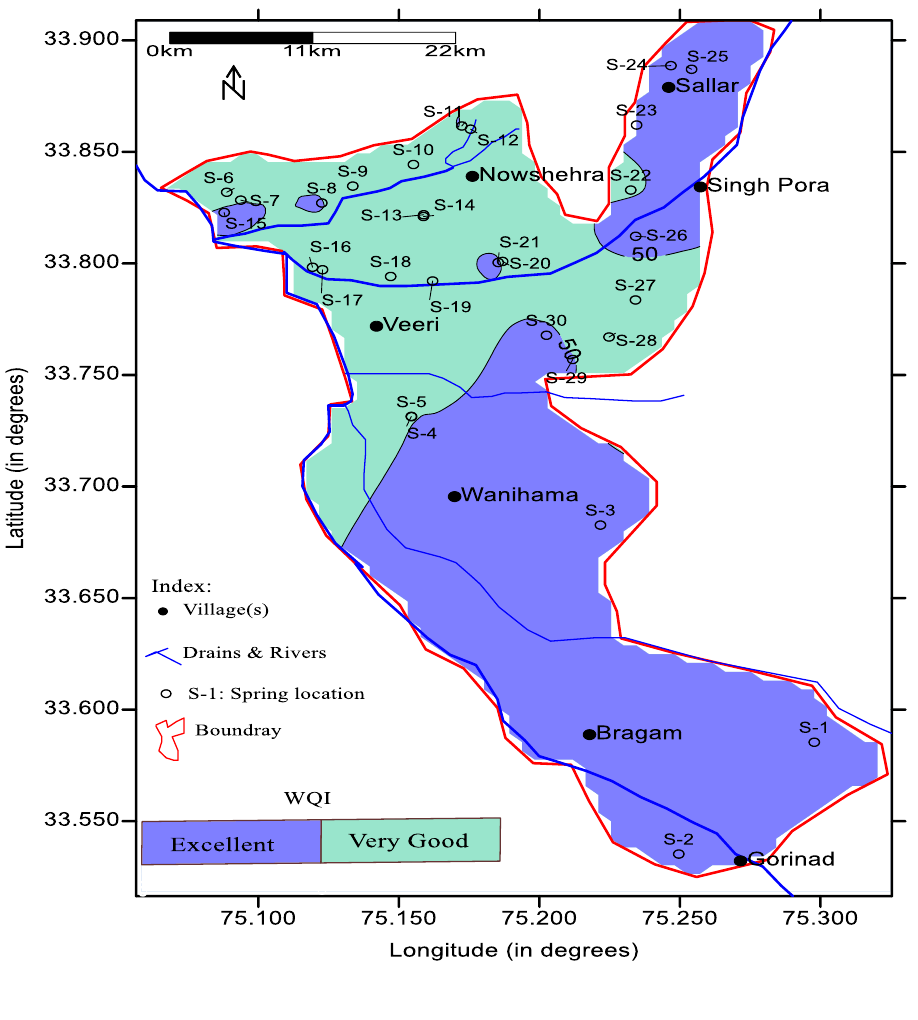
Fig. 8 Water quality map